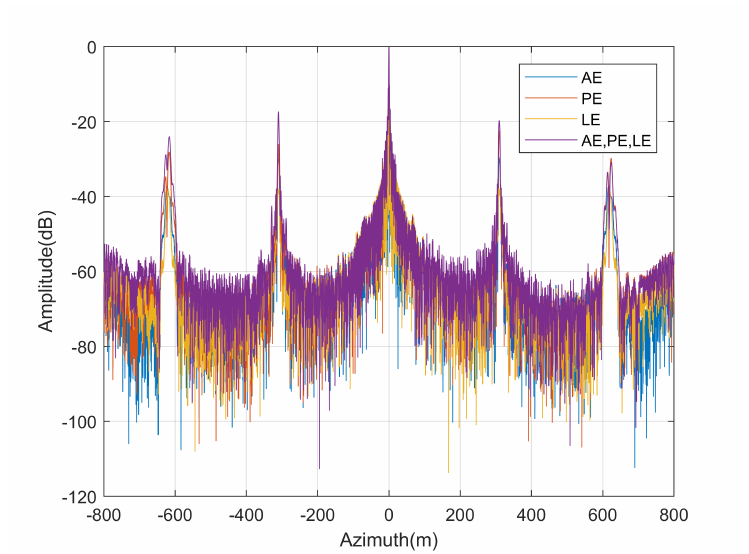
Figure 5. The azimuth profile of of the reconstruction results with different errors.